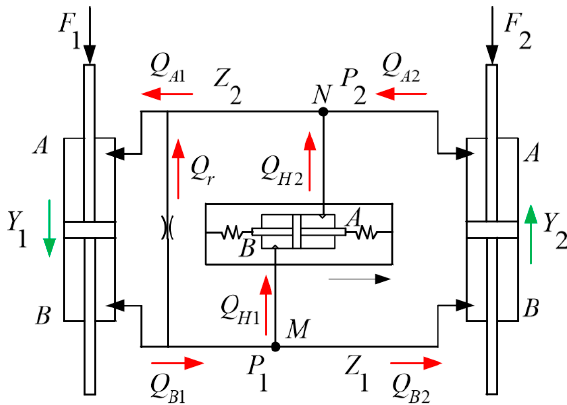
Figure 3. Simplified model of the hydraulic anti-kink system.